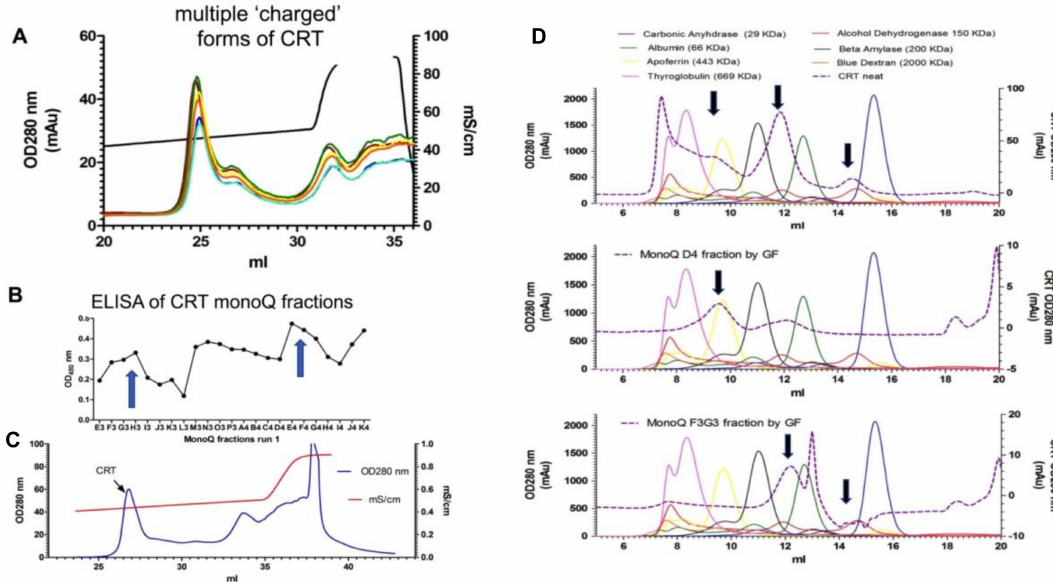
Figure 4. Chromatographic analysis demonstrating recombinant calreticulin forms various molecular complexes and charged complexes. ( A ) Multiple runs of purified recombinant CRT from E. coli (Intas) eluted from an anion exchange MonoQ column with 0–1 M NaCl. The first peak eluted at 240 mM NaCl, however a higher-charged complex elutes with >300 mM NaCl. ( B ) ELISA confirmed the various peaks were CRT and not contaminated proteins. The arrows depict the CRT content of the two major peaks shown in (A). ( C ) The two major peaks were pooled and re-run to confirm that the charge differences were retained. ( D ) Size exclusion chromatography showing elution of CRT (dotted line); CRT elutes as several molecular weight masses (black arrows) compared with standard proteins (top graph). Fractions D4 and F3G3 obtained from anion exchange MonoQ that were subsequently subjected to gel filtration confirmed that the purified protein fractions peak-D4 (middle) and fraction F3G3 (bottom graphs) were of different molecular masses of >443 and 60 kDa,